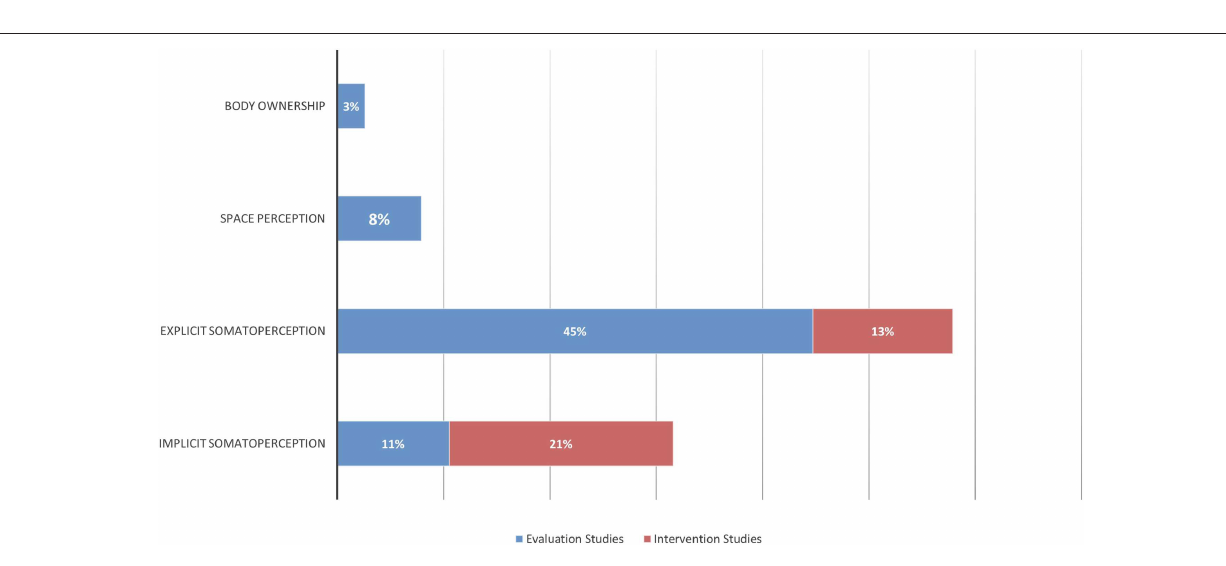
FIGURE 4 | Summary of the distribution of domain investigated for study